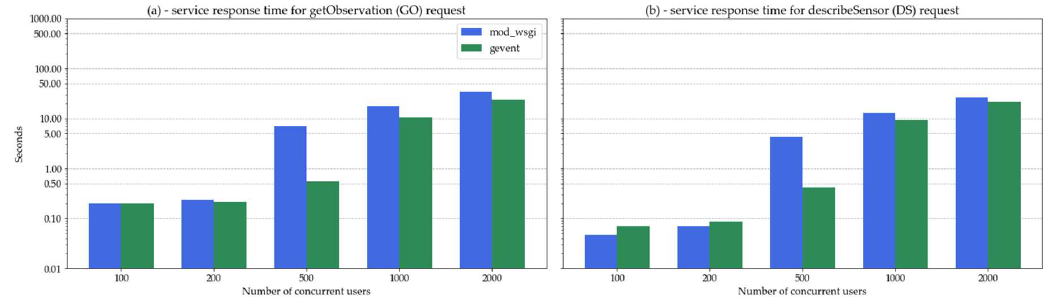
Figure 7. Service response time for the getObservation ( a ) and describeSensor ( b ) SOS requests in test case C (Springs and Wells Monitoring Network in Ticino) after excluding getCapabilities requests from the test.